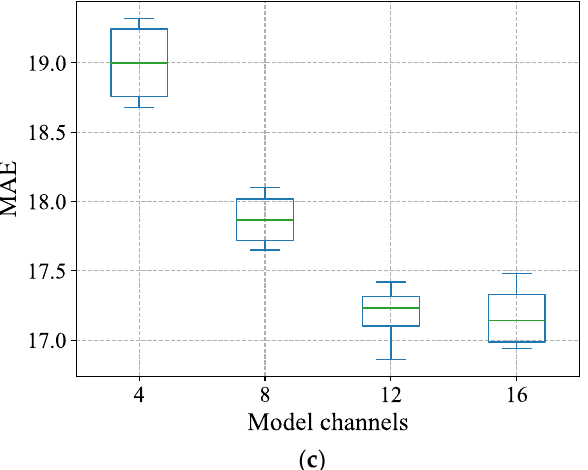
Figure 8. Parameter study. ( a ) Stacked layers; ( b ) group size; ( c ) model channels.